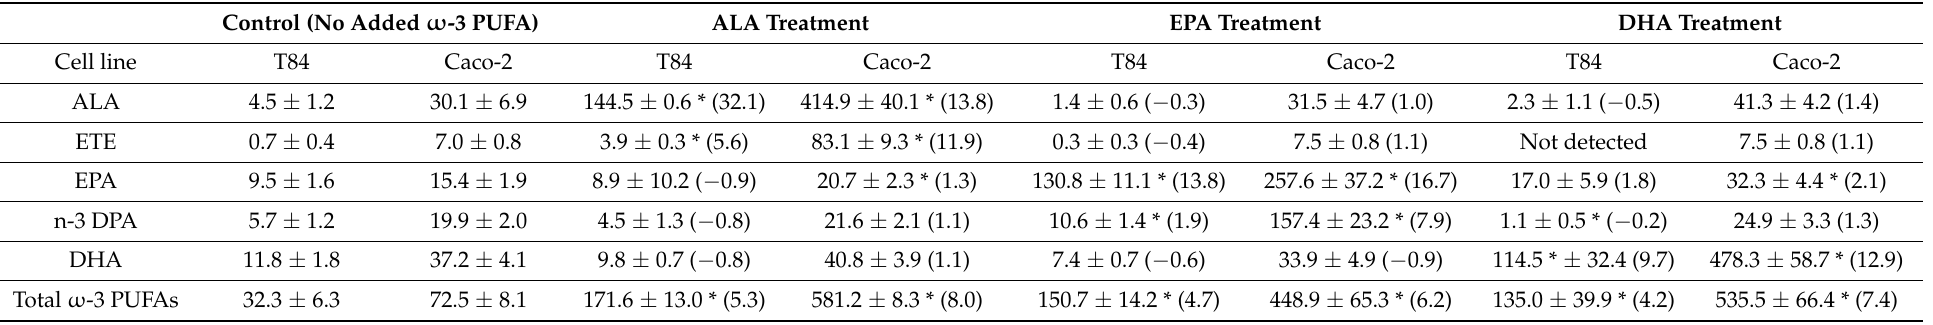
Table 2. Fatty acid content changes in gut epithelial cell lines (T84 and Caco-2) after 7 days of supplementation with ALA, EPA or DHA. Fatty acid content is given as mean picomoles of fatty acid per microgram of protein ± standard error, () indicate fold change compared to control. * Significant differences between treatment and control. Data are from